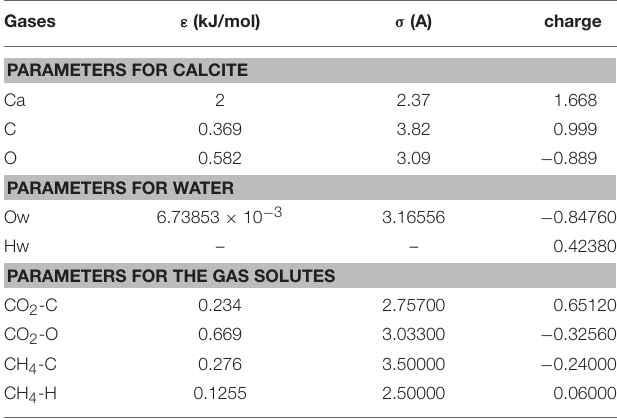
TABLE 1 | Lennard–Jones 6–12 potential